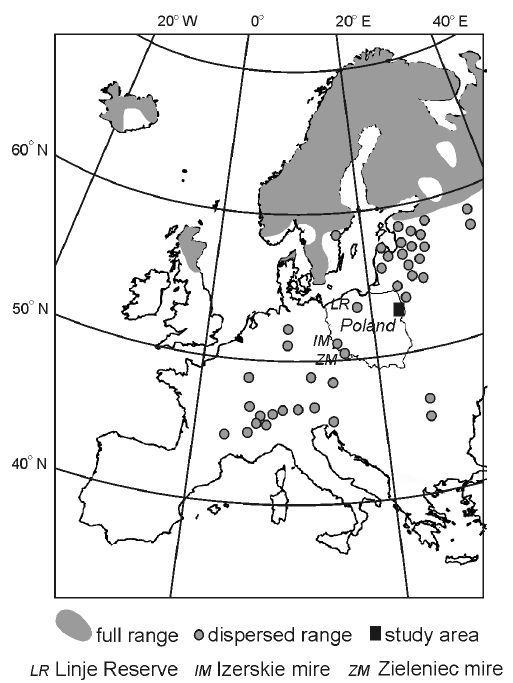
Fig. 1. Contemporary range of Betula nana L. in Europe (according to Polish Red Data Book of Plants; chapter: (cid:145) Betula nana L. Dwarf birch(cid:146) by Kruszelnicki & Fabiszewski 2001; slightly modified). Indication of the study